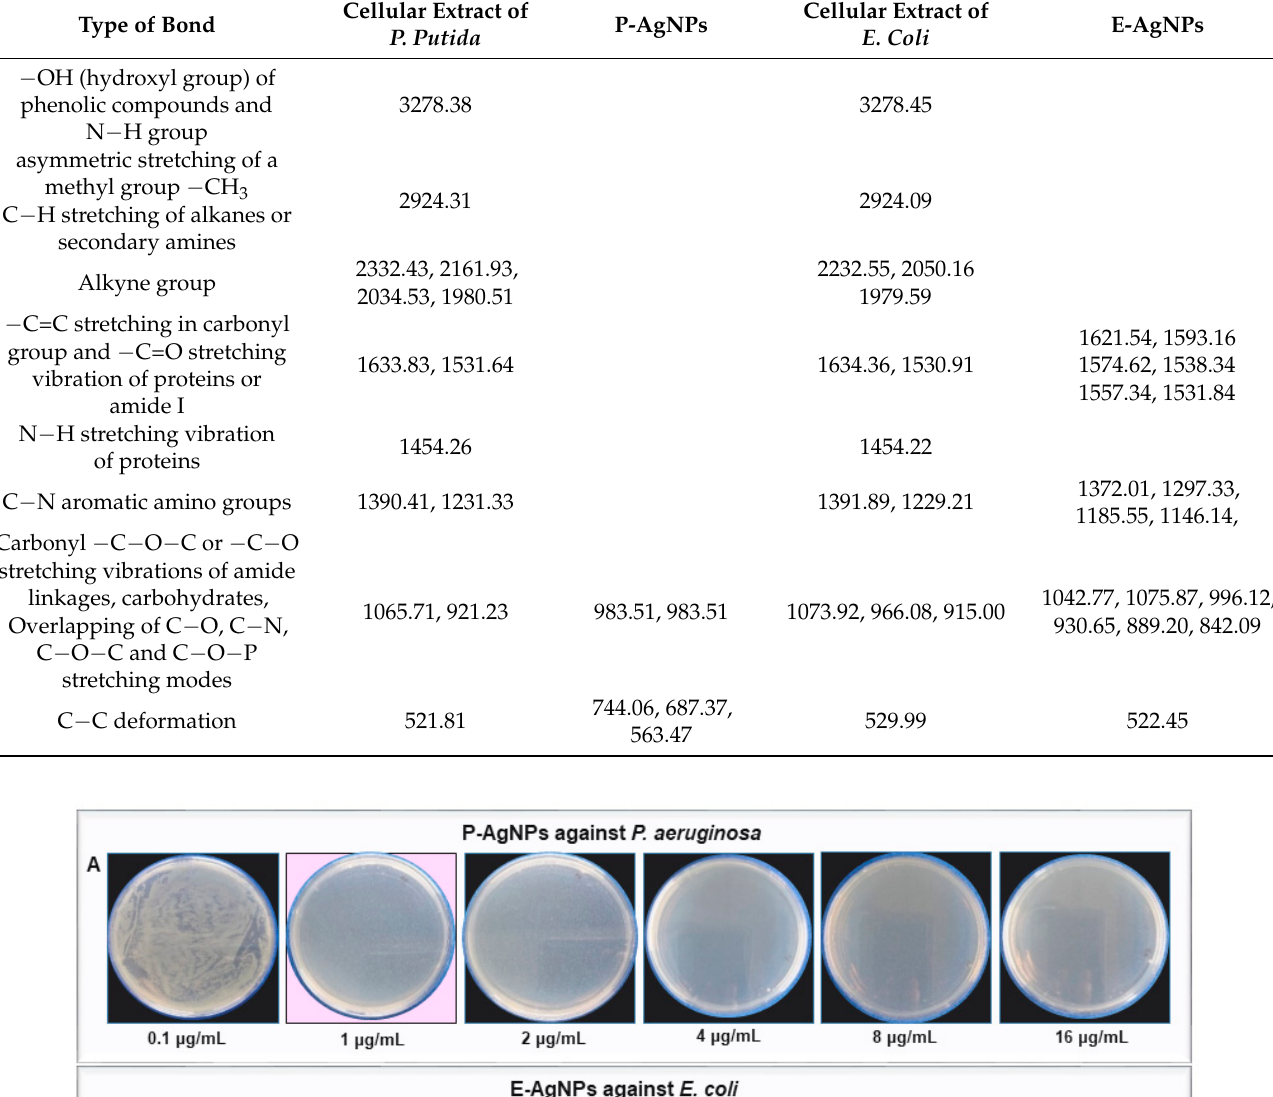
Table 1. Fourier transform-infrared spectroscopy (FT-IR) spectra for cellular extract of P. putida , E. coli , P-AgNPs and E-AgNPs.